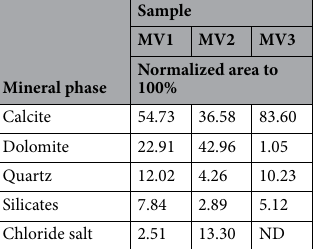
Table 1. EPMA results of mineral phase area % in MV1, MV2, and MV3.